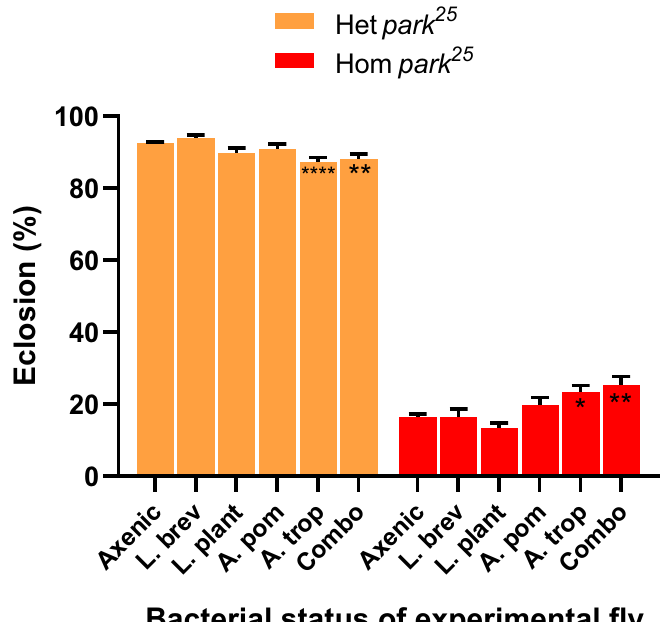
Figure 6. Mono-association with A. tropicalis or a combination of bacteria with park 25 flies can alter eclosion rate. Embryos from park 25 flies were made axenic and then mono-associated with four different laboratory bacterial strains, or inoculated with an equal CFU combination of the four strains (Combo). Pupae count and eclosion was recorded from each vial. Heterozygous (Het) park 25 pupae were differentiated from the homozygous (Hom) park 25 pupae by the presence of the Tubby marker on the TM6C balancer chromosome. Data are presented as mean and SEM. Post-hoc Dunnett’s analysis comparing to the axenic flies are shown: **** = P < 0.0001, ** = P < 0.01, * = P < 0.05. Axenic ( n = 160), L. brev = Lactobacillus brevis ( n = 24), L. plant = Lactiplantibacillus plantarum ( n = 37), A. pom = Acetobacter pomorum ( n = 35), and A. trop = Acetobacter tropicalis ( n = 37), combination ( n =